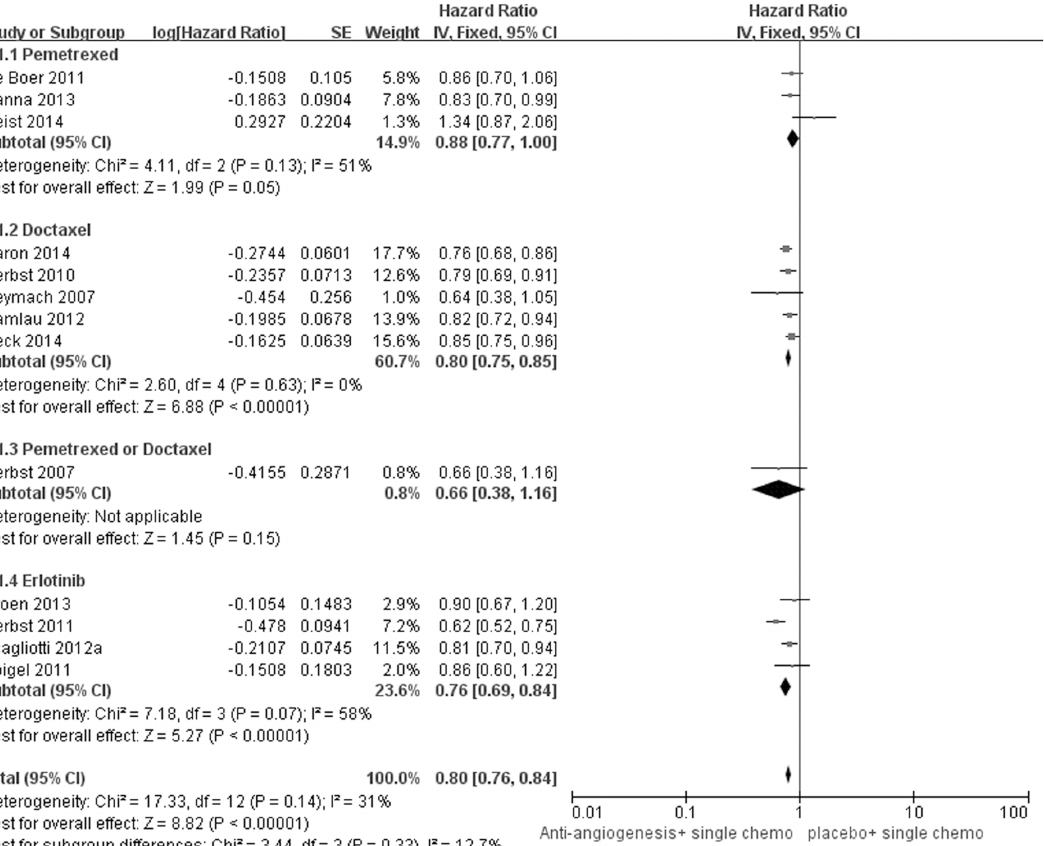
Fig 3. Forest plot and pooled HR & 95%CI for PFS: Antiangiogenic agents plus single agent chemotherapy versus standard second-line chemotherapy.